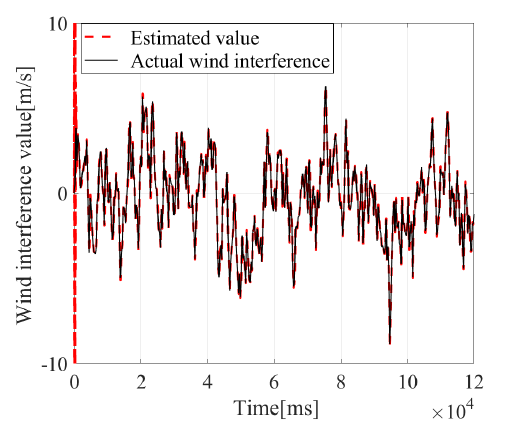
Fig. 9. Wind disturbance estimation in the vertical direction.